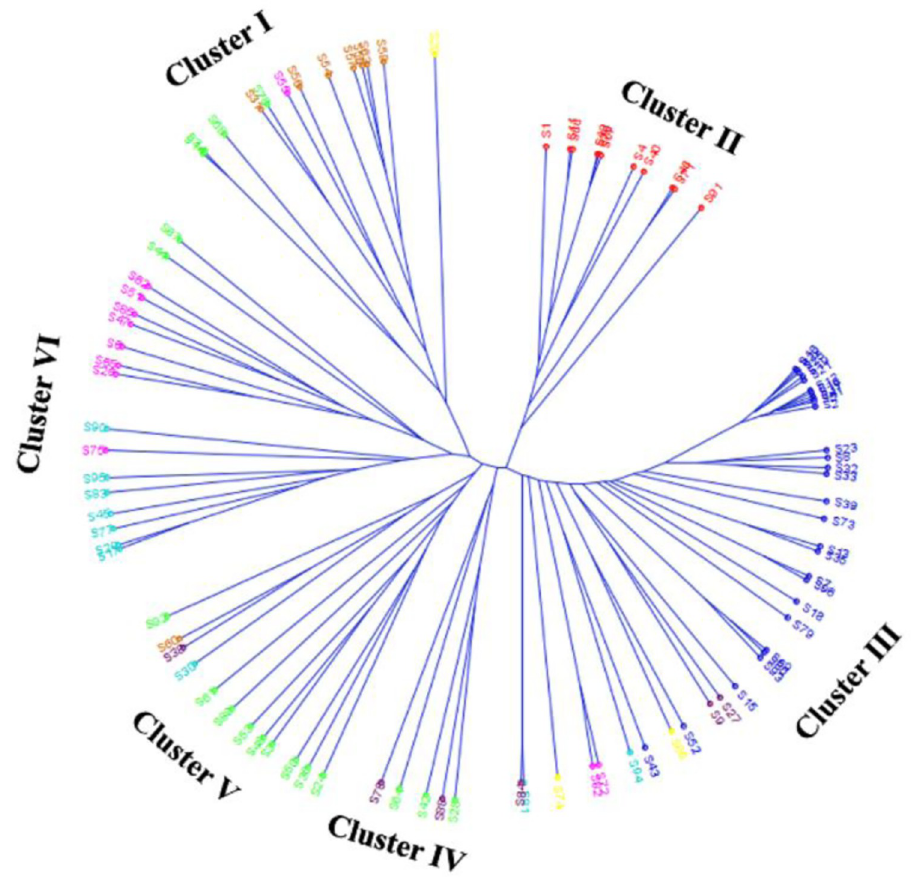
Fig 4. UPGMA based hierarchical clustering of genotypes using SNP